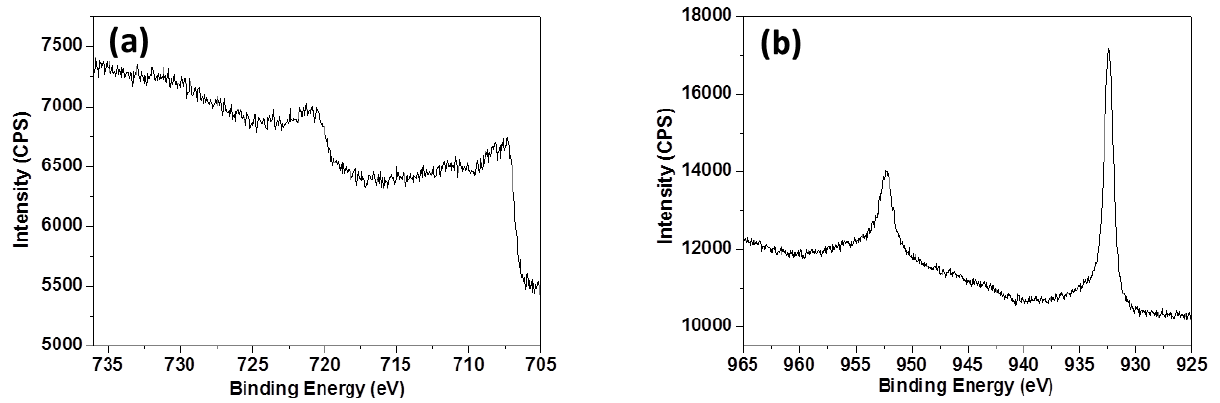
Figure 6. XPS spectra collected from the chalcopyrite surface in contact with pyrite (galvanic cell) leached for 30 h at 750 mV, 75 °C and pH 1.0: ( a ) Fe 2p; ( b ) Cu